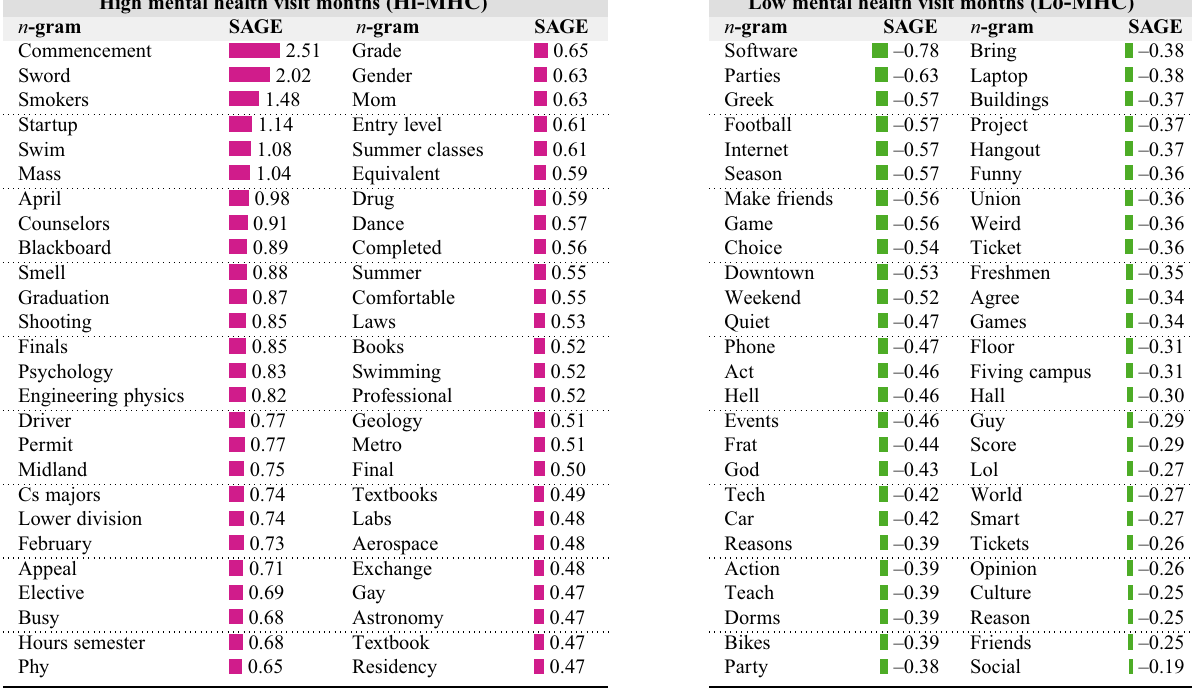
Table 2. Top salient n -grams ( n = 1, 2, 3) distinguishing months of high and low mental health visits as per SAGE 49 . Bar lengths and color indicate magnitude and sign of SAGE value; pink bars (positive SAGE) indicate a saliency in Hi-MHC months whereas green bars (negative SAGE) indicate a saliency in Lo-MHC